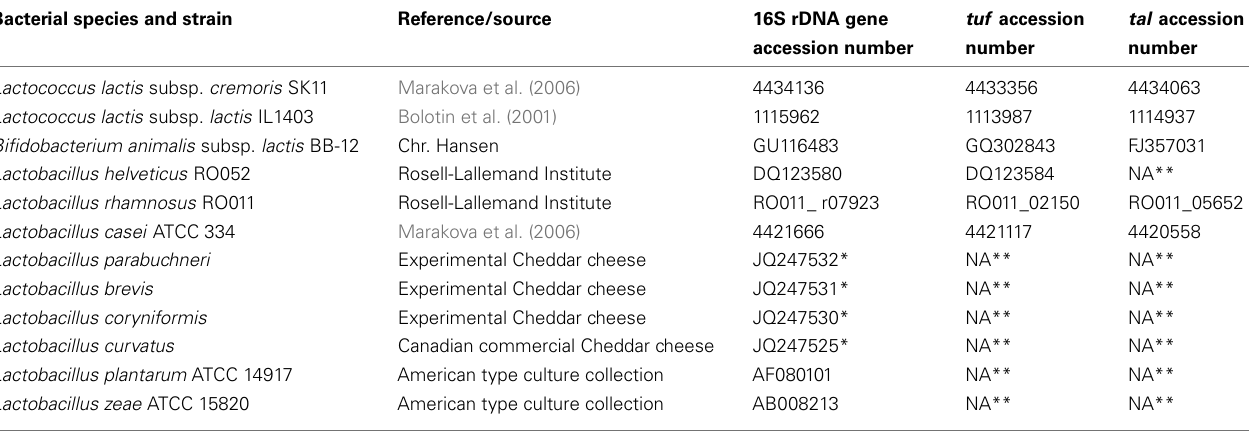
Table 1 | Genomic DNA and 16S rDNA, tuf and tal sequences used for primer design and testing. Bacterial species and